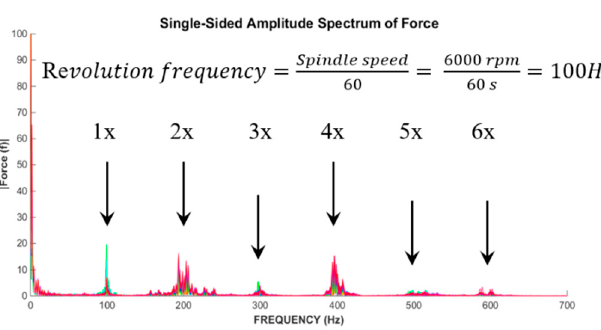
Figure 14. Thrust force signal single-sided amplitude spectrum (6000 rpm–0.15 mm/rev) [27].